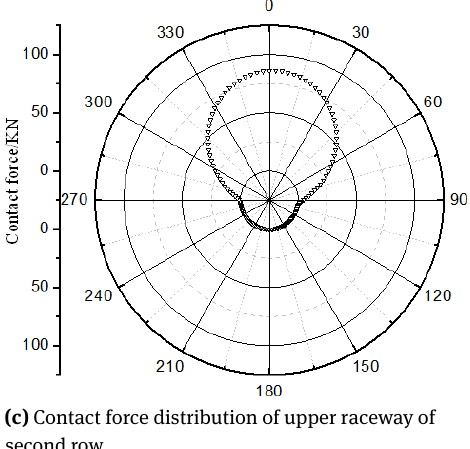
Figure 7: Contact force distribution in polar coordinates with rigid